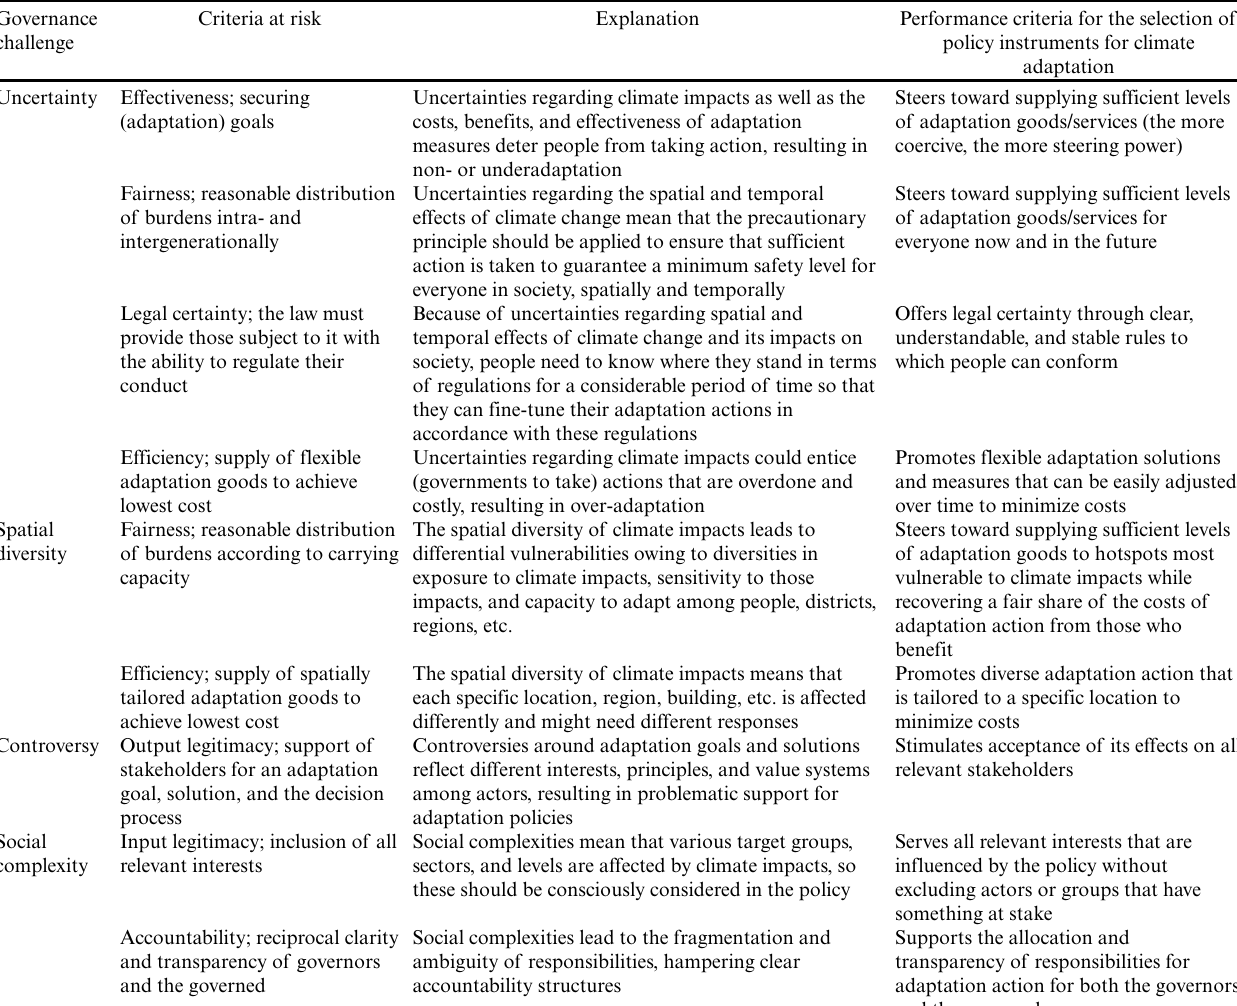
Table 2. Adaptation-specific performance criteria for the selection of policy